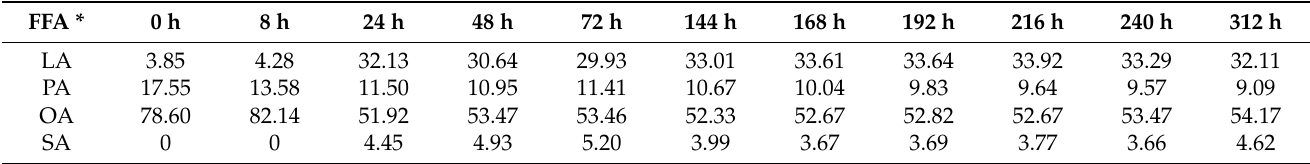
Table 1. FFA percentages of total FFAs measured in the media at different time